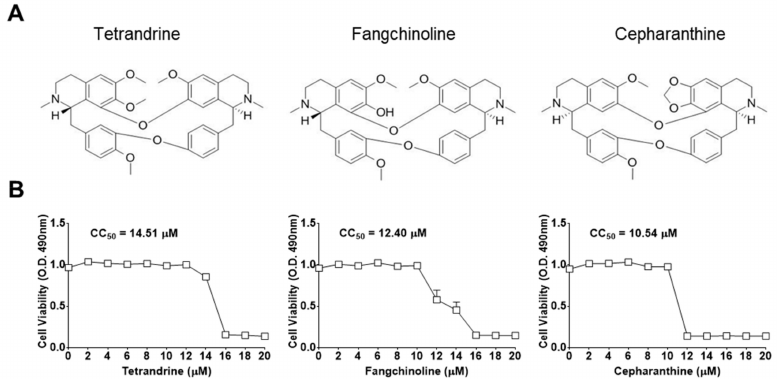
Figure1. Chemicalstructuresandthe50%cytotoxicconcentration(CC 50 )valuesofbis-benzylisoquinoline alkaloids tetrandrine (TET), fangchinoline (FAN), and cepharanthine (CEP). ( A ) Chemical structures of TET, FAN, and CEP. ( B ) MRC-5 cells were cultured from 20 µ M for four days. Cell viability was assessed using the 3-(4,5-dimethylthiazol-2-yl)-5-(3-carboxymethoxyphenyl)-2-(4-sulfophenyl)-2H-tetrazolium (MTS) assay, and the cytotoxic concentration (CC 50 ) values of the compounds were calculated. Data are presented as mean ± SEM of three independent